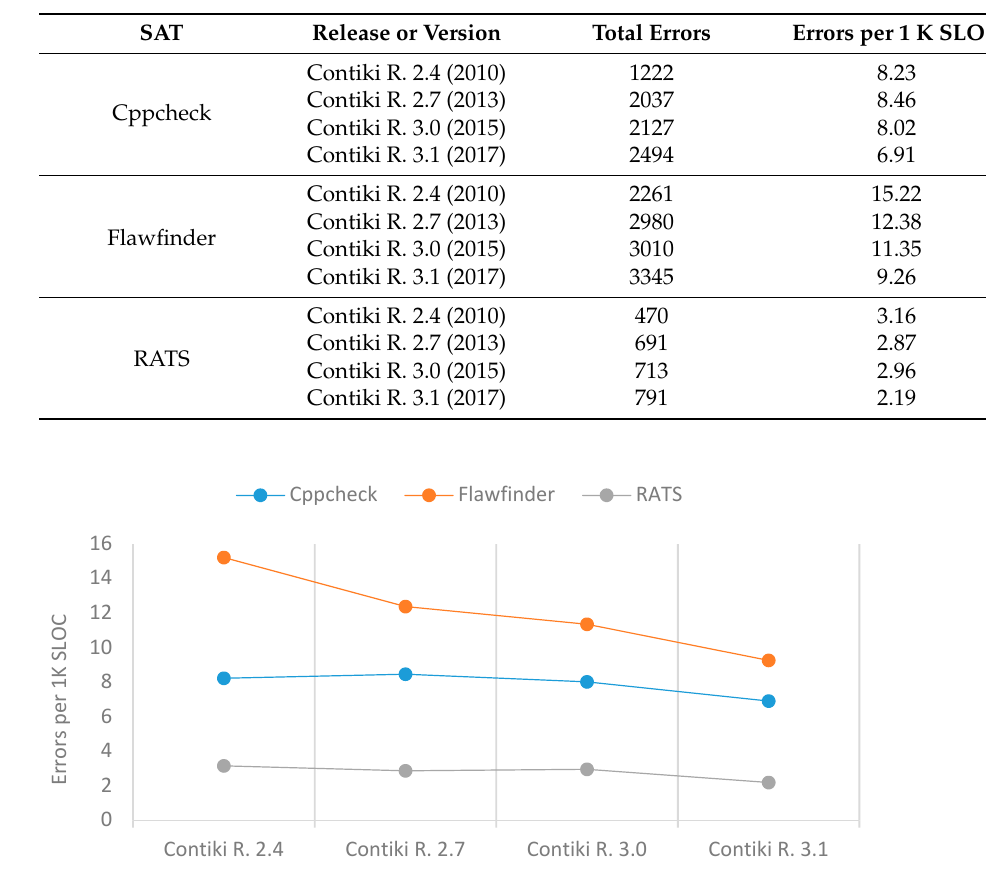
Table 5. Total errors and errors per 1 K SLOC of Contiki.